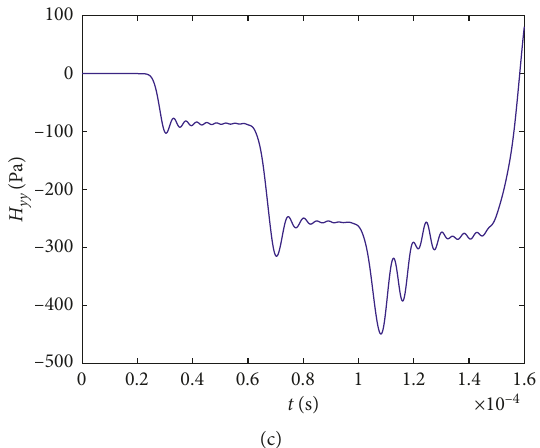
(or A ) of the specimen; (b) at the point A 1 2 (or A ) 2mm from A 8 9